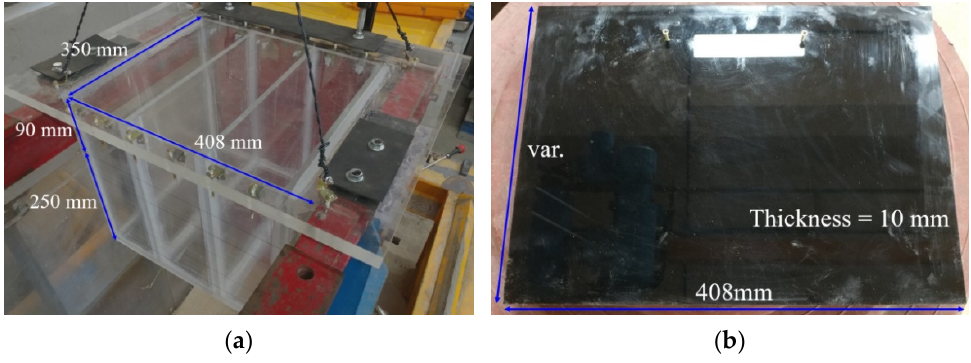
Figure 4. Scaled test model: ( a ) box structure; ( b ) SFP (stiff material).